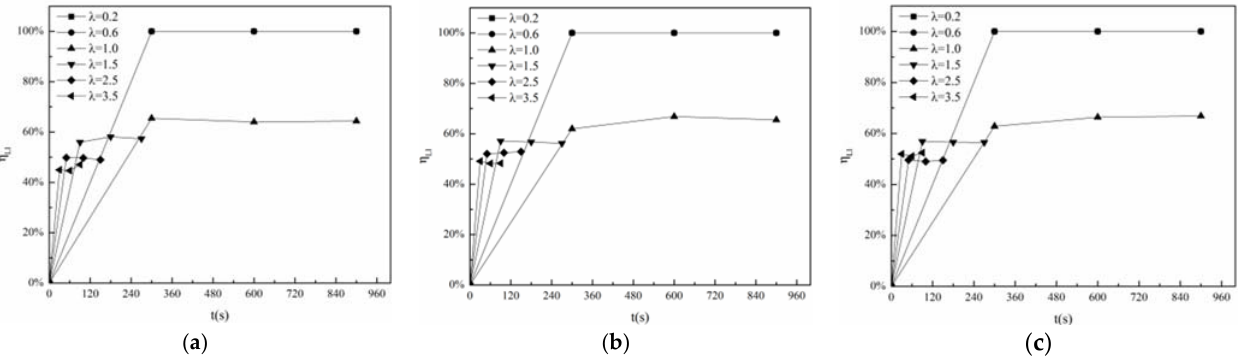
Figure 13. Left icing limit: ( a ) d = 20 mm; ( b ) d = 30 mm; ( c ) d = 40 mm.